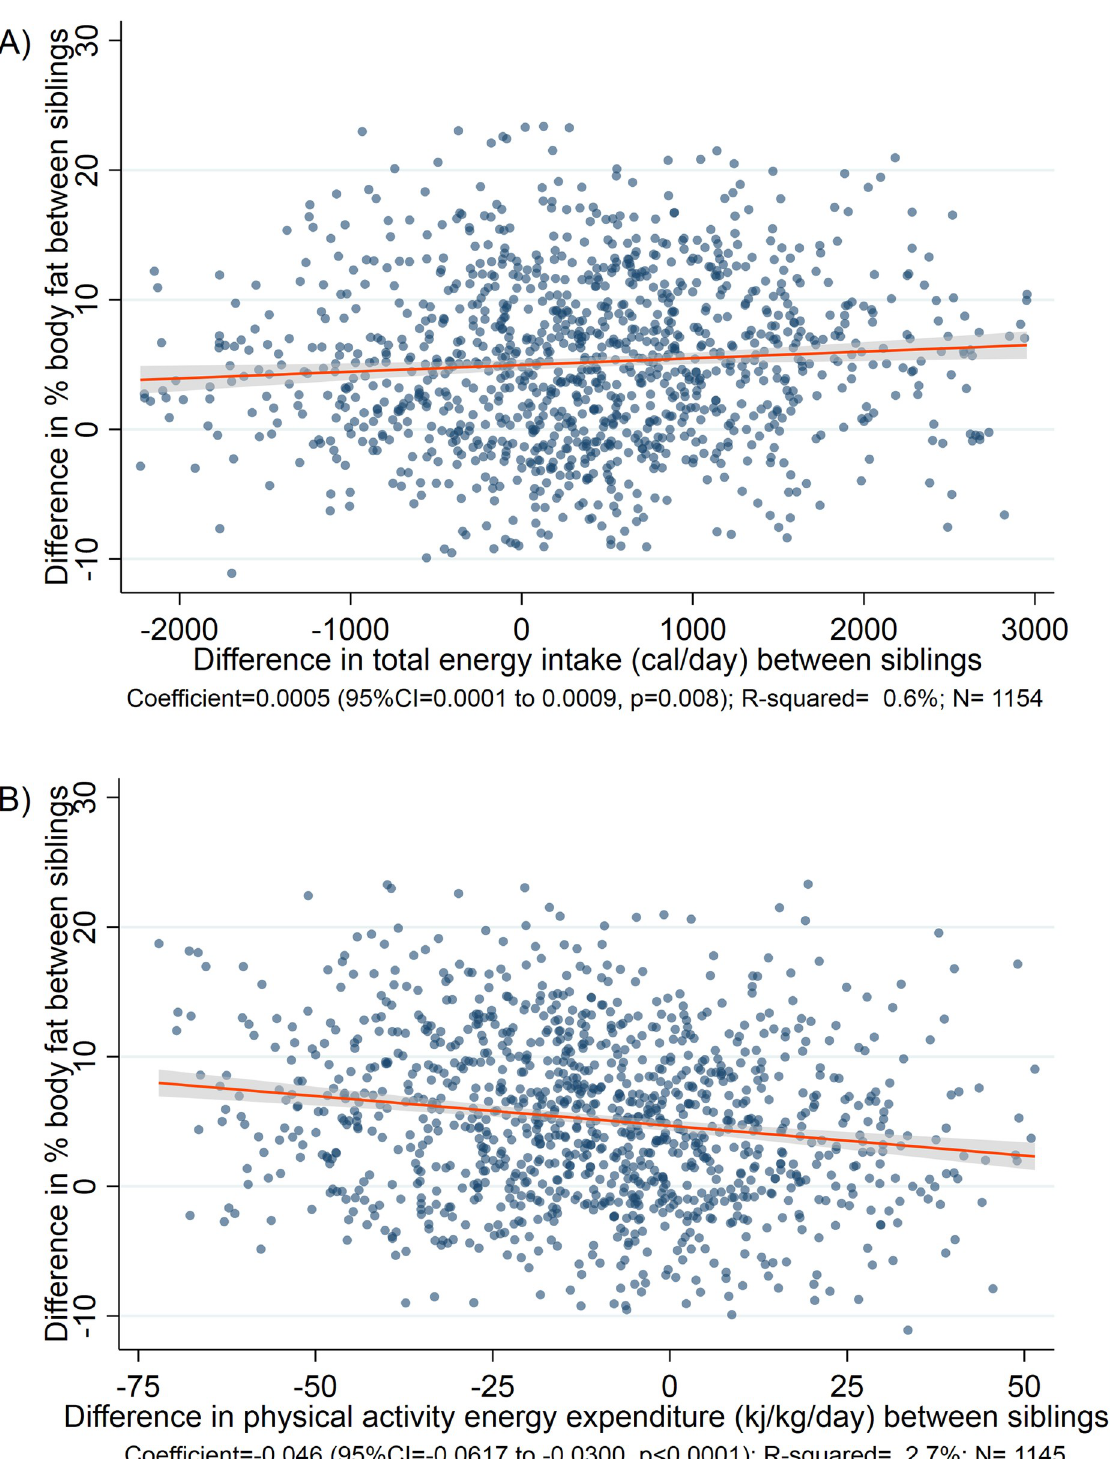
Fig 1. Unadjusted linear regression models for the association of difference in energy intake or expenditure with % body fat between urban migrant and rural sibling, Indian Migration Study, 2005–2007. A) Association of difference in energy intake and % body fat between urban migrant and rural sibling. (B) Association of difference in energy expenditure and % body fat between urban migrant and rural sibling.